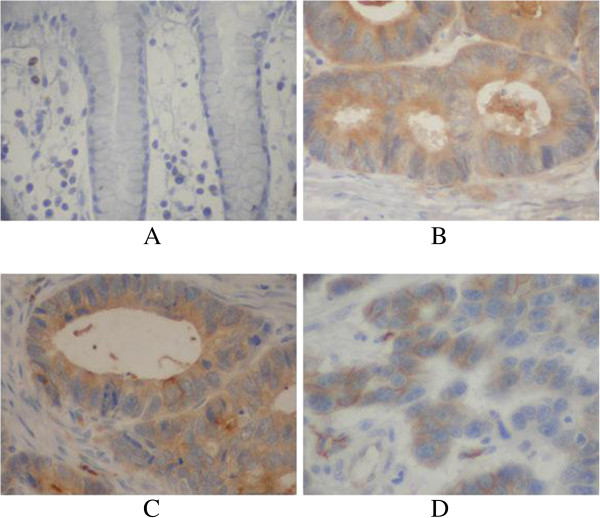
Immunohistochemical staining for L1CAM in gastric cancer lesions (601 case) and noncancerous tissues (92 case). A: L1CAM was negative in noncancerous tissues, B: L1CAM was highly expressed in well differentiated adenocarcinoma, C: L1CAM was highly expressed in moderately differentiated adenocarcinoma, D: L1CAM was highly expressed in poorly differentiated adenocarcinoma.